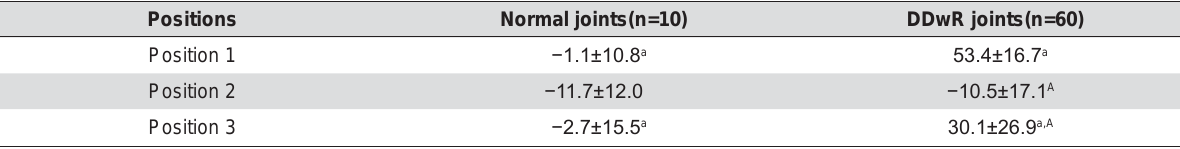
Table 1- (cid:3)(cid:39)(cid:76)(cid:86)(cid:70)(cid:16)(cid:70)(cid:82)(cid:81)(cid:71)(cid:92)(cid:79)(cid:72)(cid:3)(cid:68)(cid:81)(cid:74)(cid:79)(cid:72)(cid:86)(cid:3)(cid:73)(cid:82)(cid:85)(cid:3)(cid:87)(cid:75)(cid:72)(cid:3)(cid:87)(cid:75)(cid:85)(cid:72)(cid:72)(cid:3)(cid:83)(cid:82)(cid:86)(cid:76)(cid:87)(cid:76)(cid:82)(cid:81)(cid:86)(cid:3)(cid:76)(cid:81)(cid:3)(cid:81)(cid:82)(cid:85)(cid:80)(cid:68)(cid:79)(cid:3)(cid:68)(cid:81)(cid:71)(cid:3)(cid:39)(cid:39)(cid:90)(cid:53)(cid:3)(cid:77)(cid:82)(cid:76)(cid:81)(cid:87)(cid:86)(cid:3)(cid:11)(cid:131)(cid:15)(cid:3)(cid:80)(cid:72)(cid:68)(cid:81)(cid:147)(cid:54)(cid:39)(cid:12)